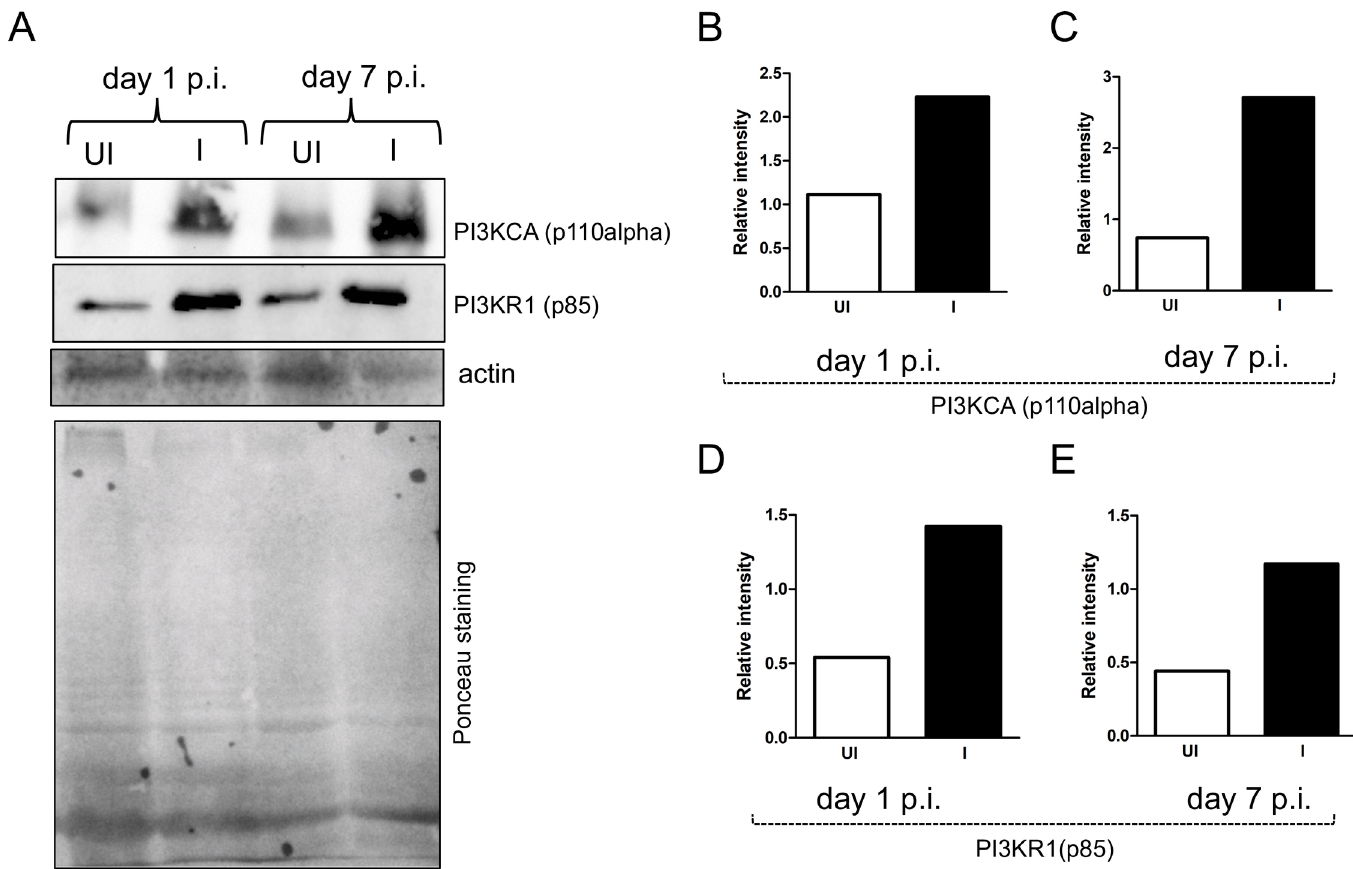
Fig 3. Altered expression of PI3KCA and PI3KR1 upon A . phagocytophilum infection of MEG-01 cells. ( A) Immunoblotting analysisshowinglevels of PI3KCA, PI3KR1 in uninfected(UI) or A . phagocytophilum -infected (I) MEG-01 cells at days 1 and 7 p.i. The levels of actin (detected by immunoblotting) and Ponceaustainedgel image for total protein serves as loadingcontrol in the immunoblotting analysis. (B) Densitometry analysisshowinglevels of PI3KCA (B and C) or PI3KR1 (D and E) at days 1 (B and D) and 7 (C and E) p.i. relative to the respective actin bandsseen in A.